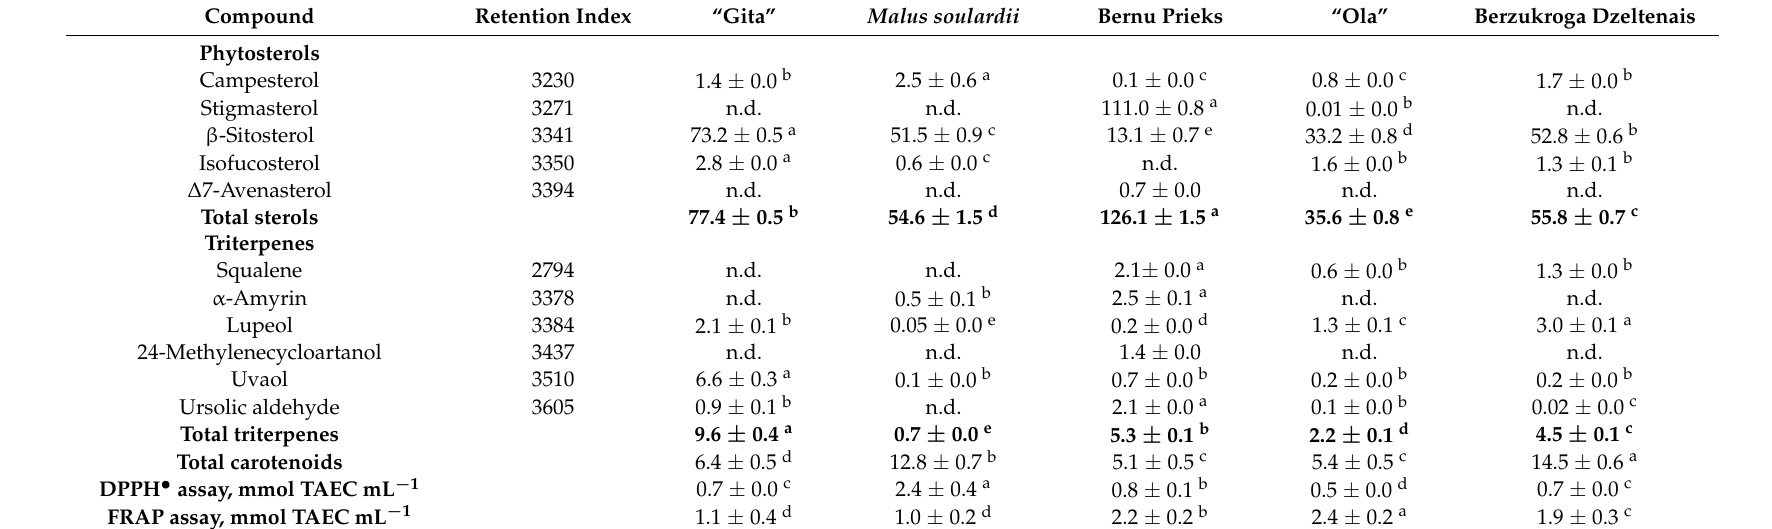
Table 3. Content of phytosterols and triterpenes in pomace oils recovered from Malus spp. crab apples, mg mL − 1